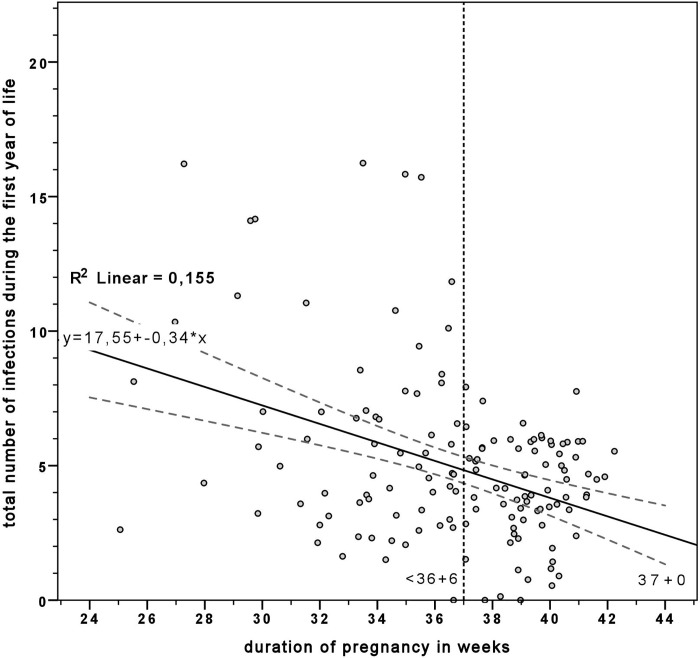
Higher risk of infection in preterm infants.Moderate, but significantly negative correlation between the maturity status and the risk of infection tested by linear regression and shown by bivariate scatter plot graph.